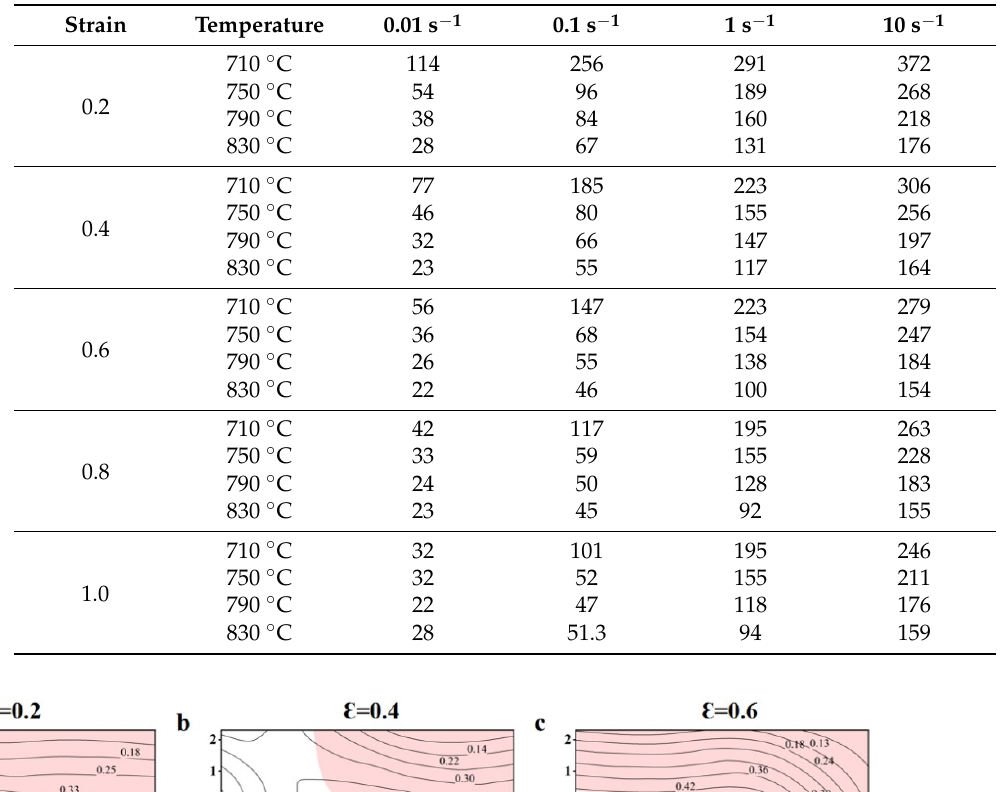
Table 2. Flow stress (MPa) of the Ti15Zr5Cu alloy at different strain rates under various deformation conditions.